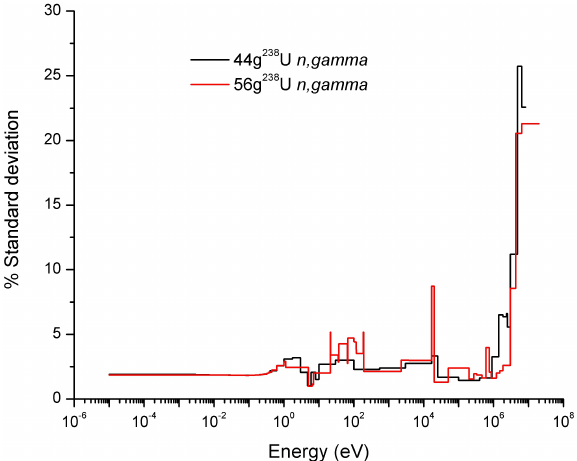
Figure 6. 238 U ( n, γ ) relative standard deviation by energy for covariance libraries 44groupcov and